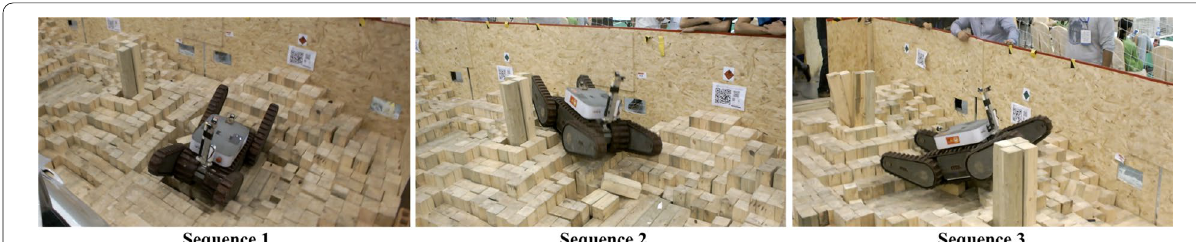
Fig. 21 The robot is maneuvering on Stepfields test of Mobility test suite